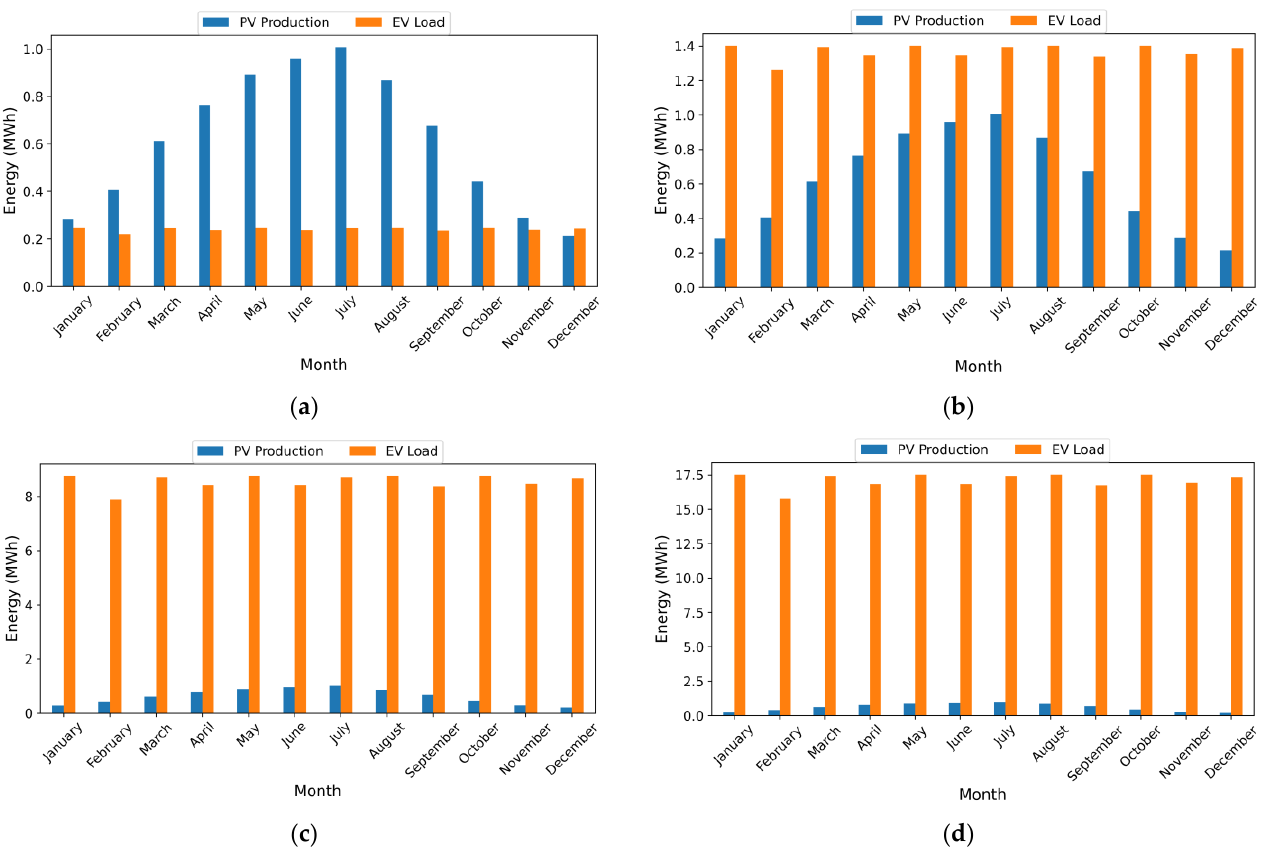
Figure 15. Monthly cumulative energy production (MWh) of the PV system and the charging load for the three levels of charging stations in the case of a type 1 home (EV user returns home at noon). ( a ) Level 1 charging station (1.4 kW). ( b ) Level 2 charging station (8 kW). ( c ) Level 3 charging station (50 kW). ( d ) Level 3 charging station (100 kW).